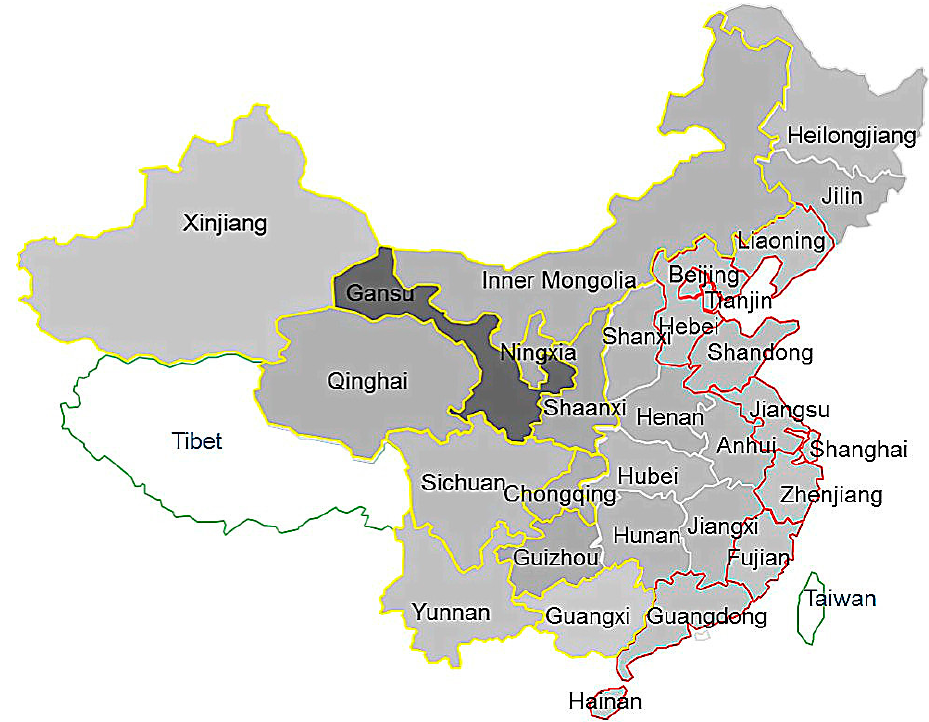
Figure 4. Dynamic performance distribution in China.